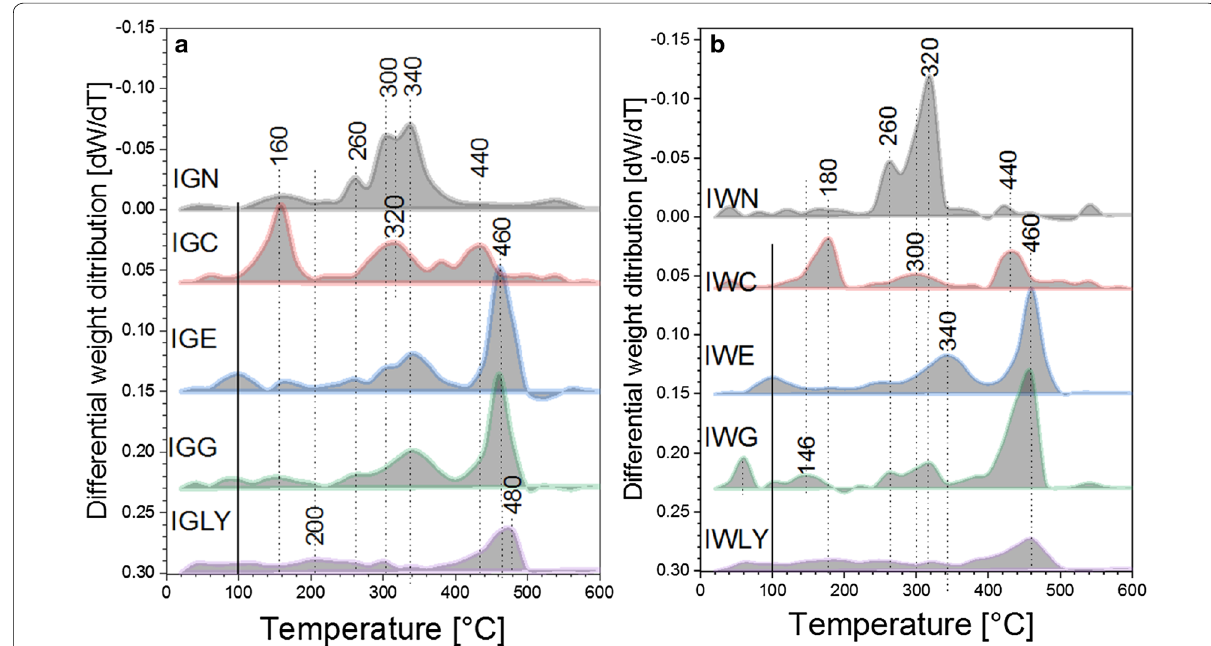
Fig. 6 DTG of Irvingia‑based adhesives